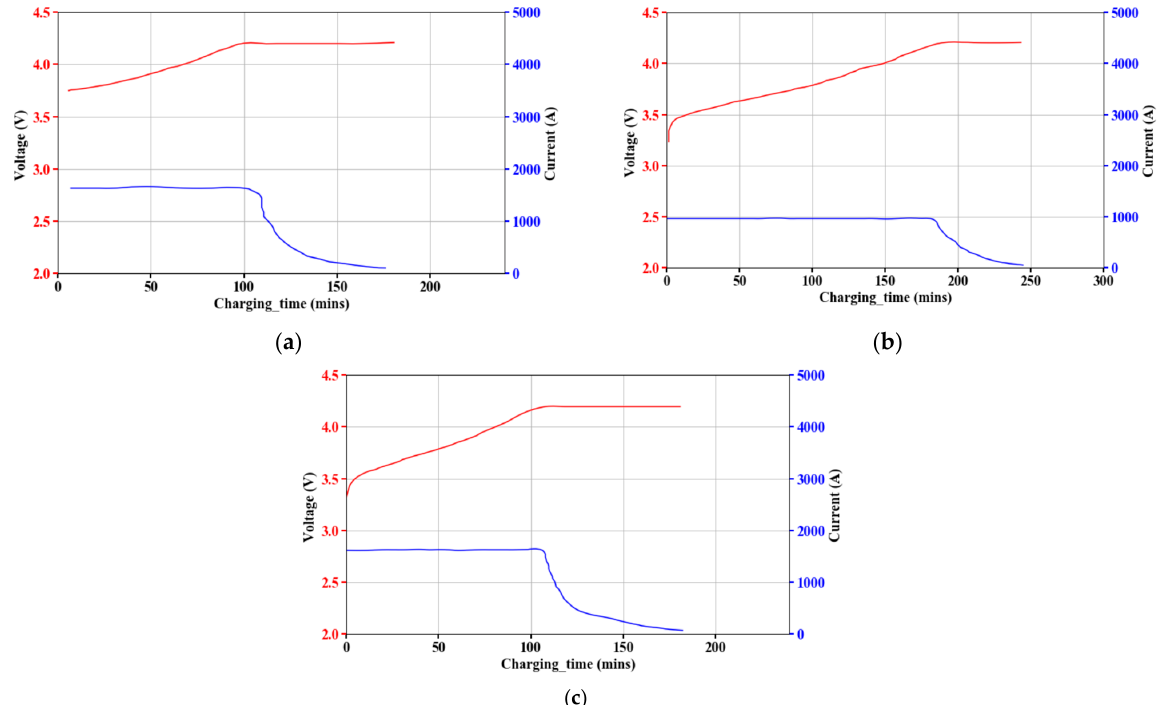
Figure 3. Observed inconsistent charge characteristics from different sources for Panasonic NCR18650B cells: ( a ) [13]; ( b ) [14]; and ( c ) [15].